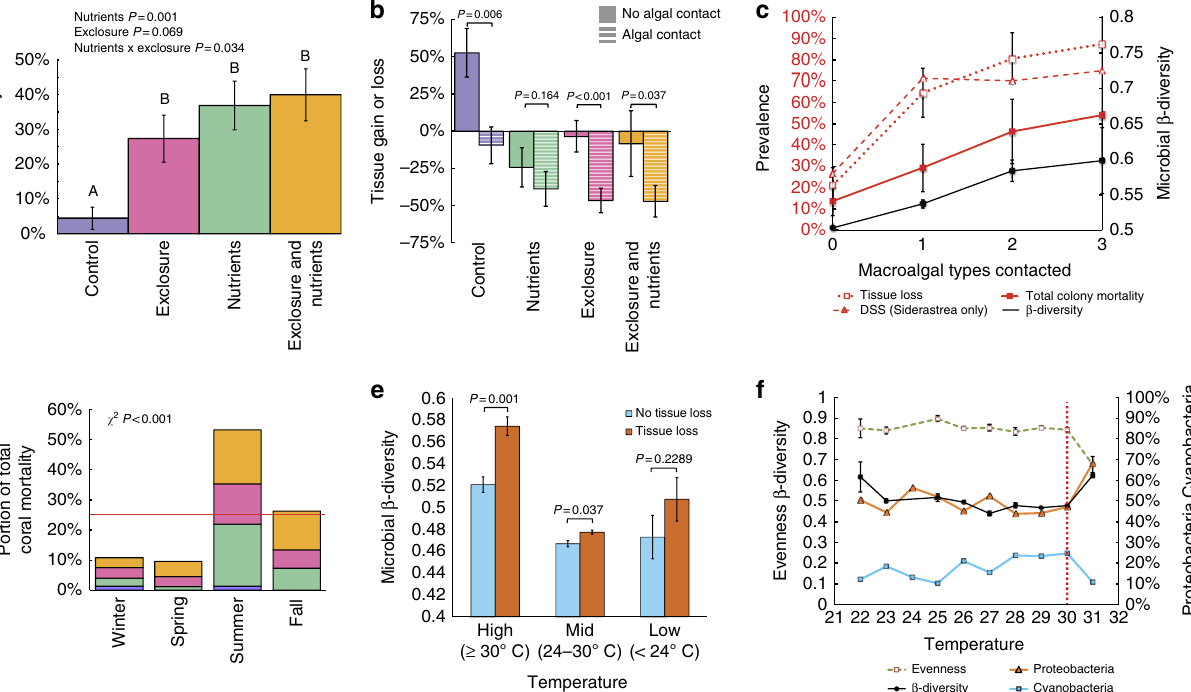
Figure 3 | Multiple stressors disrupt coral microbial communities and produce coral mortality. ( a ) Cumulative coral mortality at end of experiment. P values are from mixed effect models, letters over bars show differences in Tukey’s post hoc tests. Herbivore removal significantly increased coral mortality relative to controls (Tukey’s post hoc test P o 0.05), but not relative to nutrient pollution alone ( post hoc test and mixed effects model P 4 0.05). ( b ) Effects of algal contact on coral tissue area, across treatments. P values from ANOVAs test the effect of algal contact within each treatment. ( c ) Number of algal taxa contacting corals versus microbiome b -diversity (weighted UniFrac distance), and the prevalence of coral tissue loss, mortality and Siderastrea dark spot syndrome (DSS). ( d ) Seasonal distribution of coral mortality, coloured by treatment ( a ). Red line marks null expectation of equal mortality across seasons. P value is from a w 2 -test. ( e ) Microbial community b -diversity for corals with or without tissue loss, split by temperature. P values reflect non- parametric t -tests of distances. ( f ) Temperature effects on coral microbial variability, evenness and relative abundance of Proteobacteria or Cyanobacteria. Evenness and b -diversity data are means ± s.e.m. Microbial and coral health data are averaged within each 1 (cid:2) C interval on the x axis. The vertical red line at 30 (cid:2) C indicates the point nearest to the MMM þ 1 (cid:2) C value for our site (30.26 (cid:2) C); temperatures beyond this result in accumulation of degree heating weeks of coral thermal stress